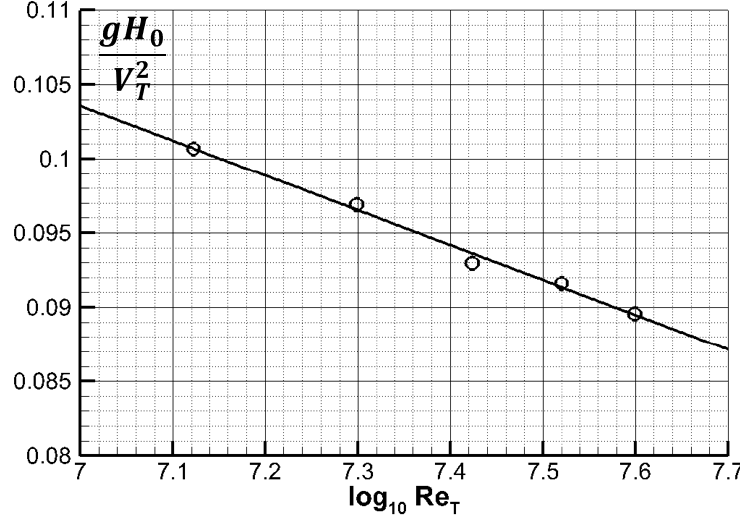
Figure 11. Head loss of the DLCT according to Reynolds numbers from the numerical results.